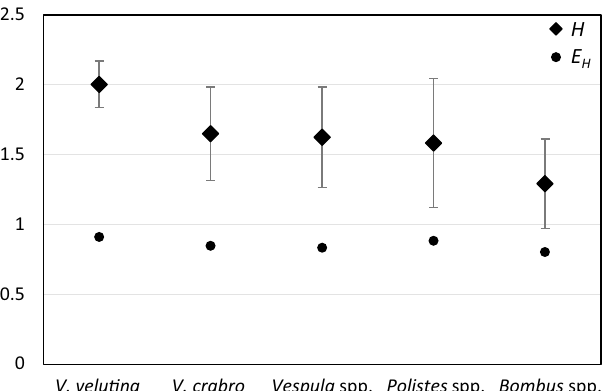
Figure 3. Parasite diversity in the different hosts. Diamonds represent the Shannon diversity Index ( H ; with 95% CIs bars) and dots the Shannon’s equitability index ( E H